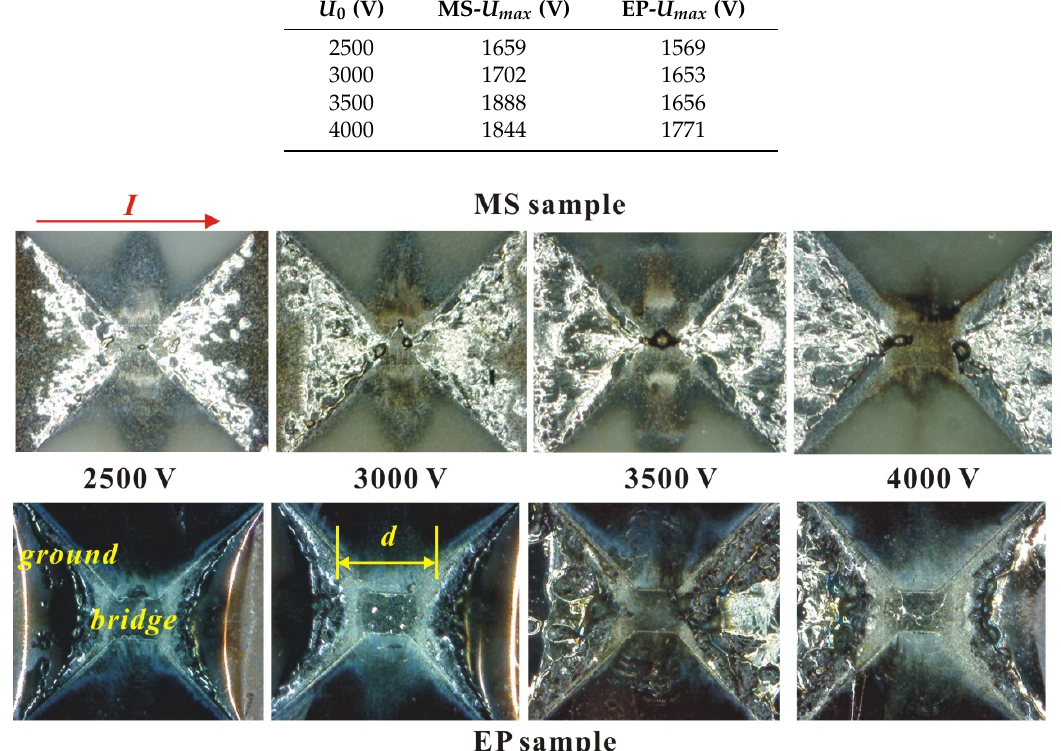
Figure 7. Morphological characteristics of two samples after electric explosion.